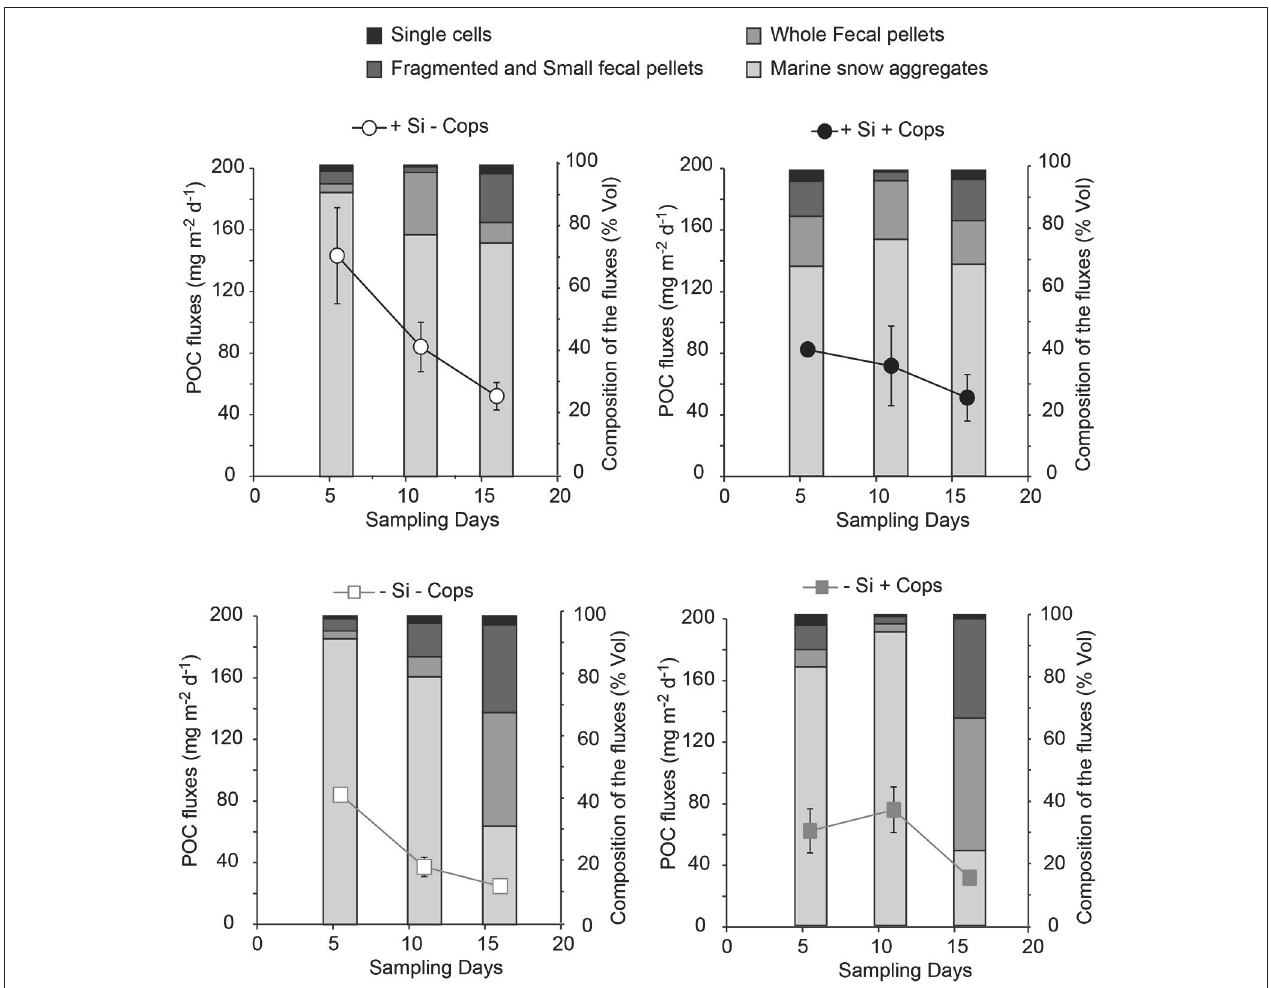
FIGURE 7 | Composition of the particle fluxes in the four treatments, measured from images of gel traps and POC fluxes in sediment